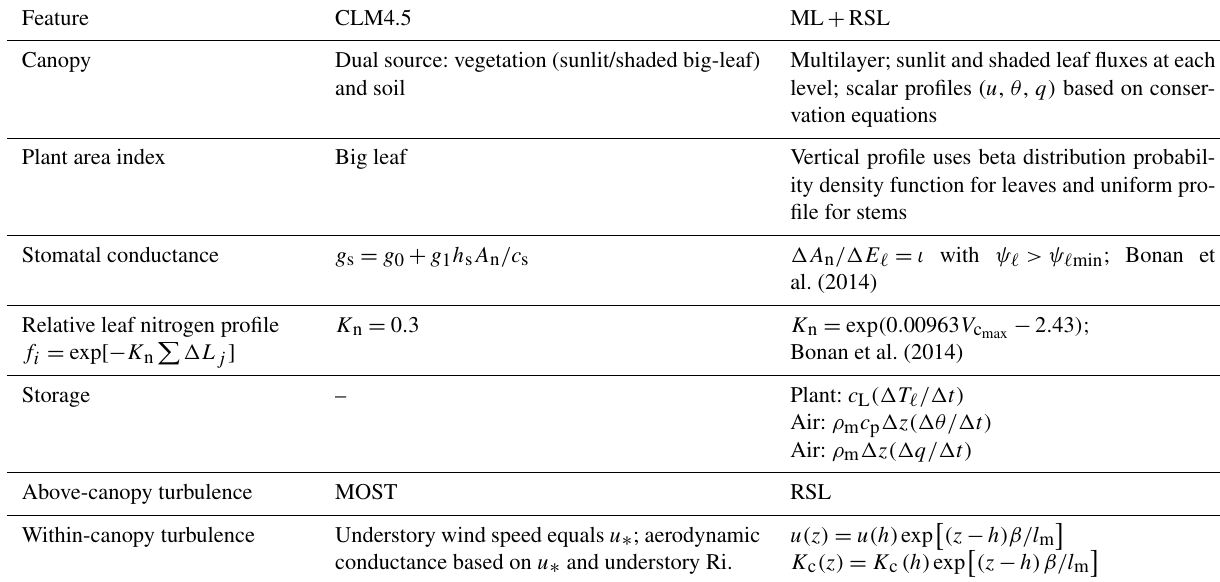
Table 3. Major differences between CLM4.5 and ML + RSL.